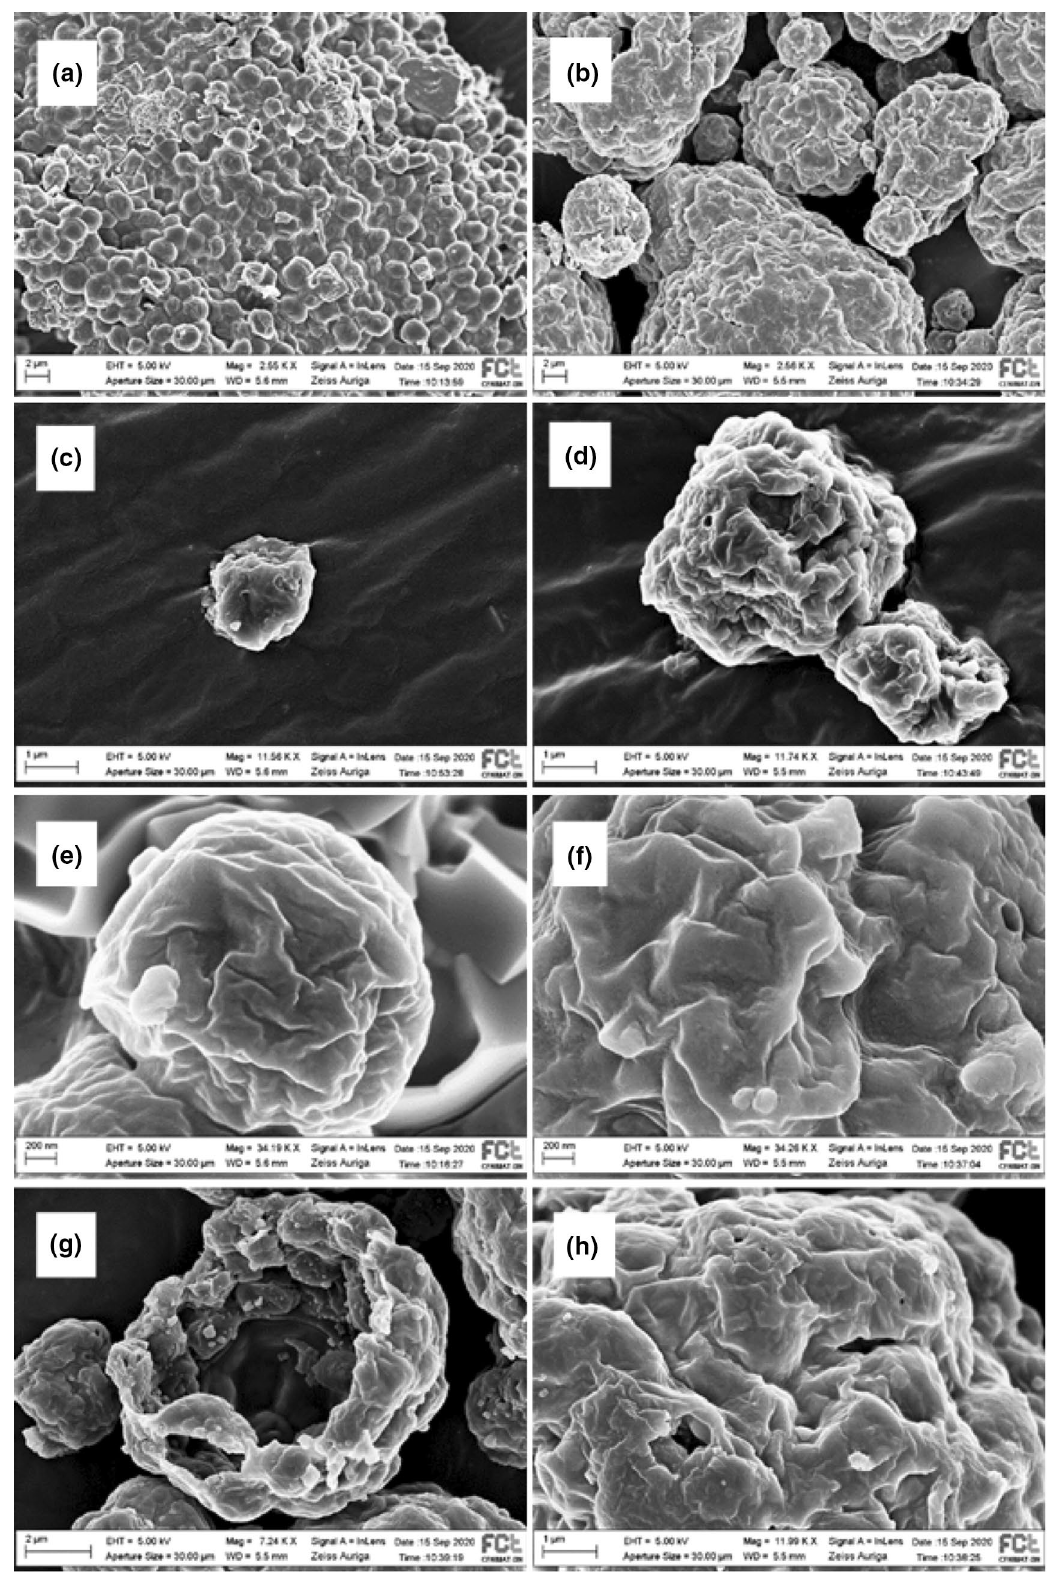
Figure 3. Scanning Electron Microscopy Focused Ion Beam (SEM–FIB) of freeze-dried (FD) and spray-dried (SD) N. oceanica . Stabilization in carbon matrix and gold–palladium coating. ( a ) Granules correspond to individualized FD N. oceanica cells; ( b ) Granules correspond to clusters of more than one SD N. oceanica cell; ( c ) Individual FD N. oceanica cell; ( d ) SD N. oceanica cells cluster; ( e ) FD N. oceanica cell wall appearance detail; ( f ) SD N. oceanica cell walls appearance in detail; ( g ) SD N. oceanica fragmented granule; ( h ) SD N. oceanica granule surface in